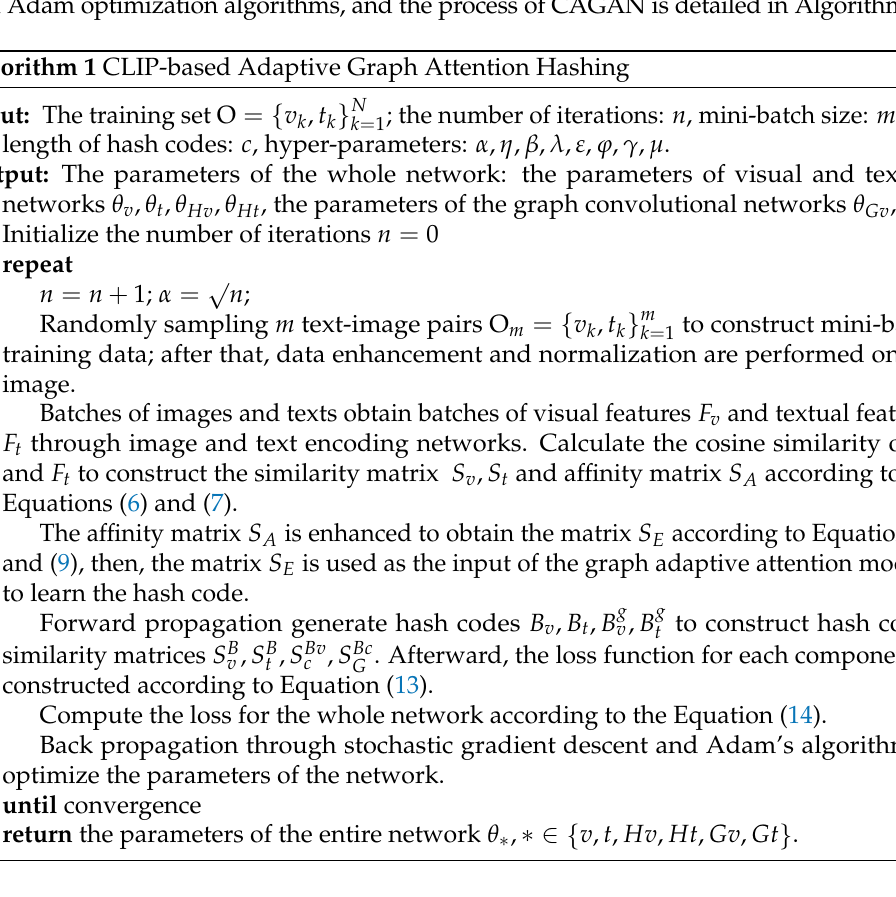
Algorithm 1 CLIP-based Adaptive Graph Attention